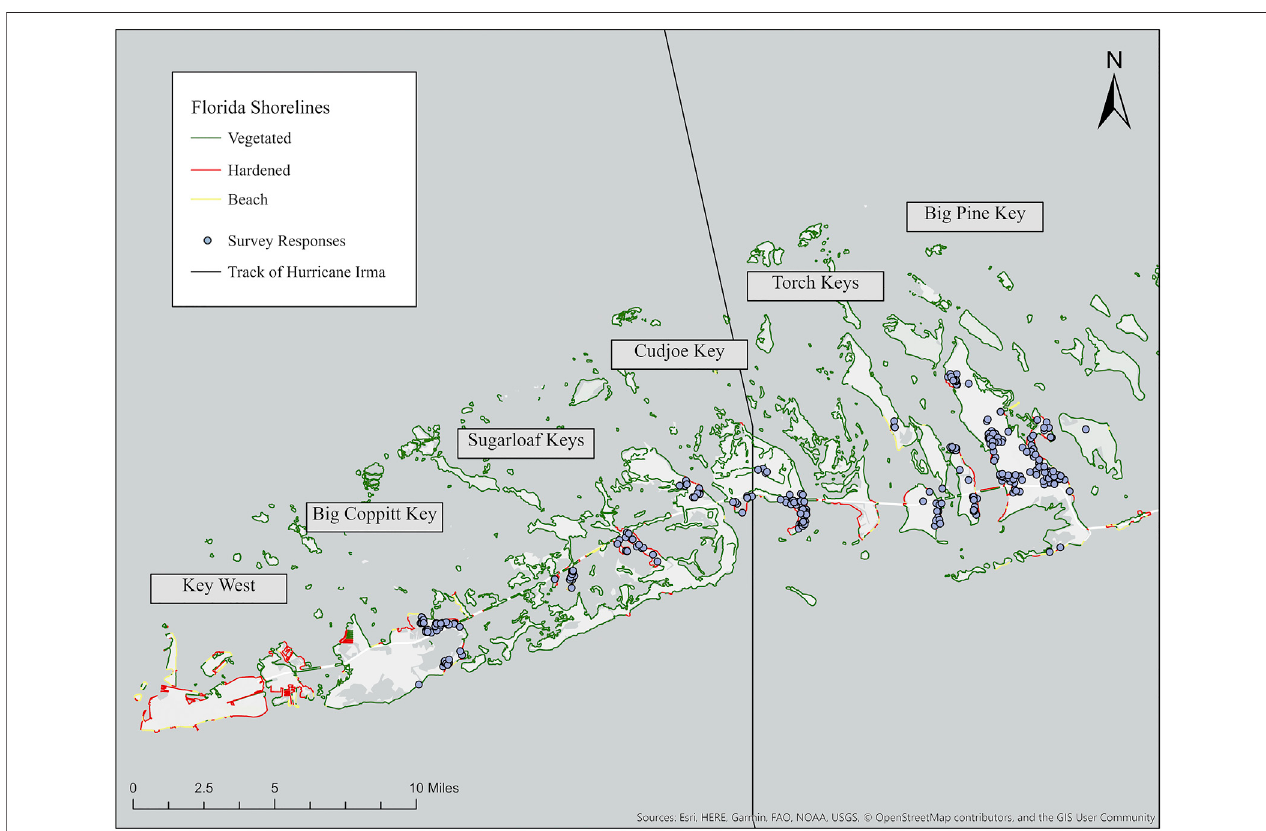
FIGURE 1 | Map of Hurricane Irma ’ s path, shoreline condition, and location of survey respondents throughout the Lower Florida Keys. The map shows the Lower FloridaKeysfromKeyWest(notsurveyed)onthewesternmostsidetoBigPineKeyontheeasternsideofthemap.TheblacklinerunningthroughCudjoeKeydepictsthe trackofHurricaneIrma.TheNOAAESIlinesre fl ecttheshorelinetypesbasedonthefollowinggroupings:hardened(seawallsorripraprevetments),vegetated(mangrove, scrub-shrub wetlands, marsh grass, etc.), and beaches. The blue dots represent the survey respondents ’ locations.